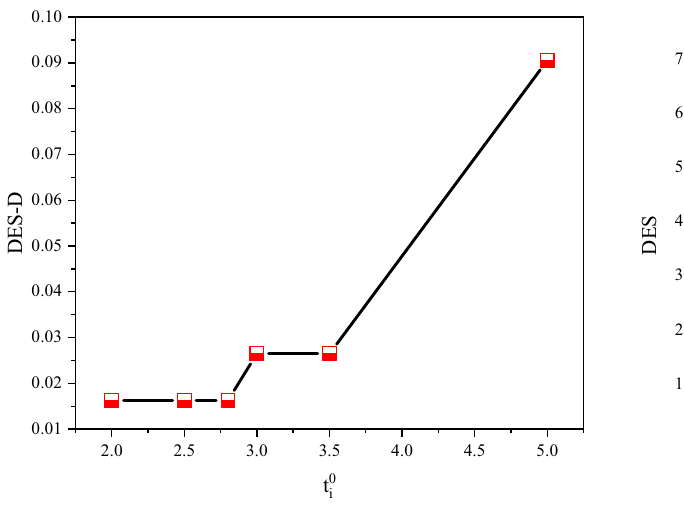
Figure 18: Relationship of DES versus t i 0 , and DES - D versus t i 0 .